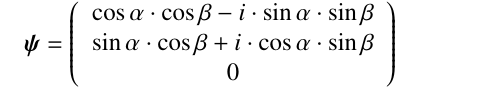
Figure 3. Calculation results of extended ray tracing in cold plasma slab with a magnetic field shear period (cid:28) s = 0 : 25. (a) - (e) have the same meaning with Fig. 1